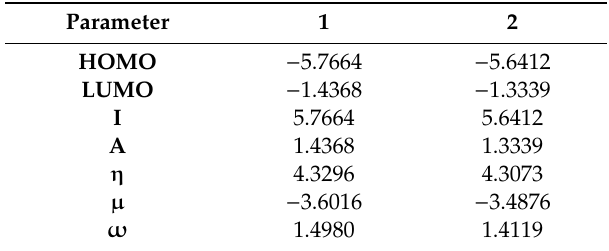
Table 3. The calculated descriptors of compound 1 , and compound 2 .